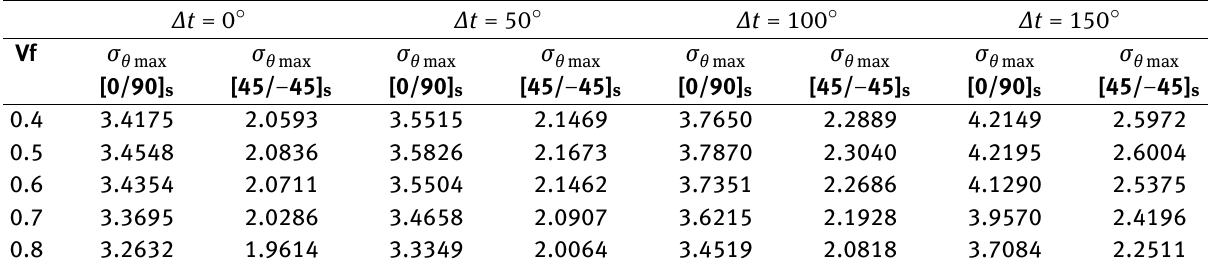
Table 5: Effect of fibre volume fraction and temperature on σ θ max ( σ ∞ x = 1 , a/b = 2, [45/ − 45]s & [0/90]s)